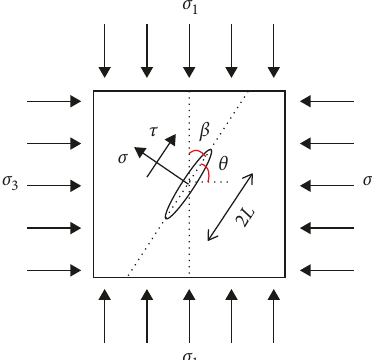
Figure 2: Calculation model of water-bearing jointed rock